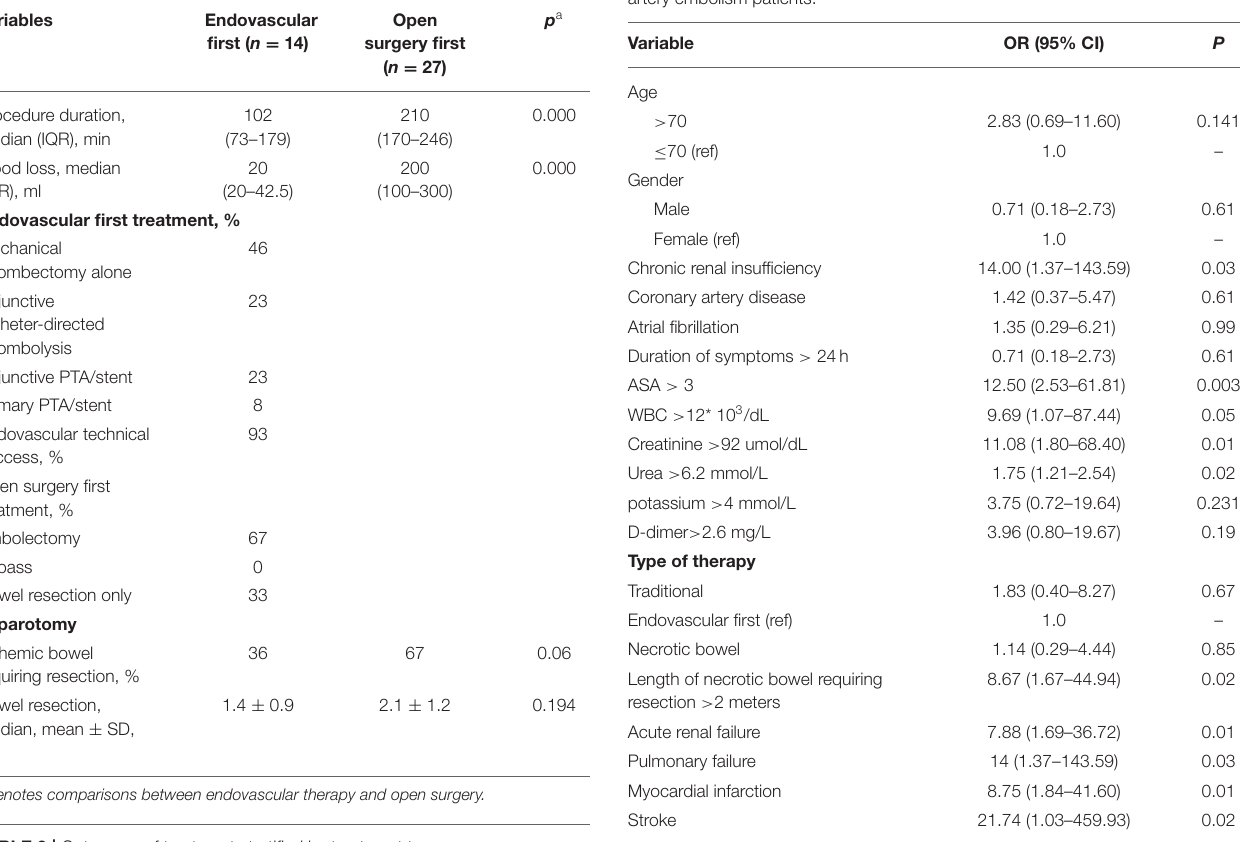
TABLE 2 | Comparison of operative management stratified by treatment type.